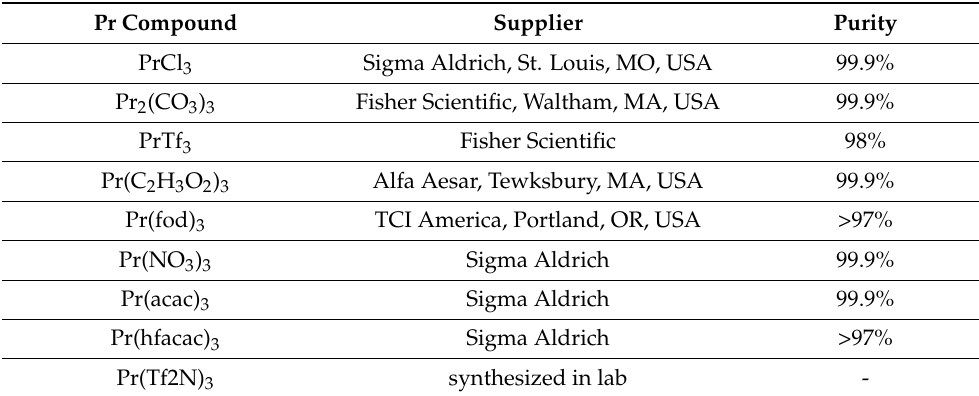
Table 5. List of Praseodymium salts with the names of their suppliers and their purity. Pr Compound Supplier